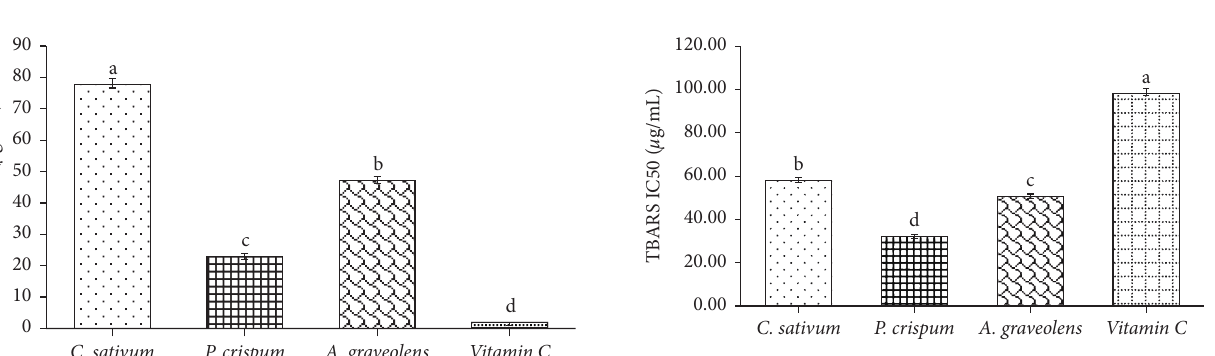
Figure 2: Antioxidant activity of the studied plant species based on DPPH assay. Amounts are mean ( n � 6) ± SE. bars followed by different lower-case letters (a–d) which are significantly different ( p < 0 . 001).